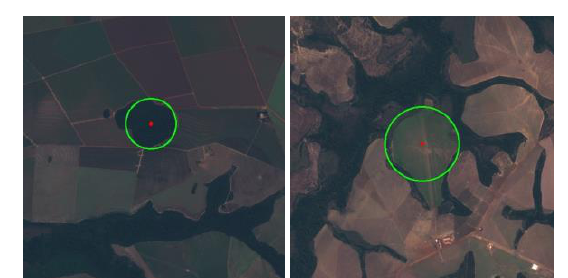
Table 2. Results of PVANET-Hough